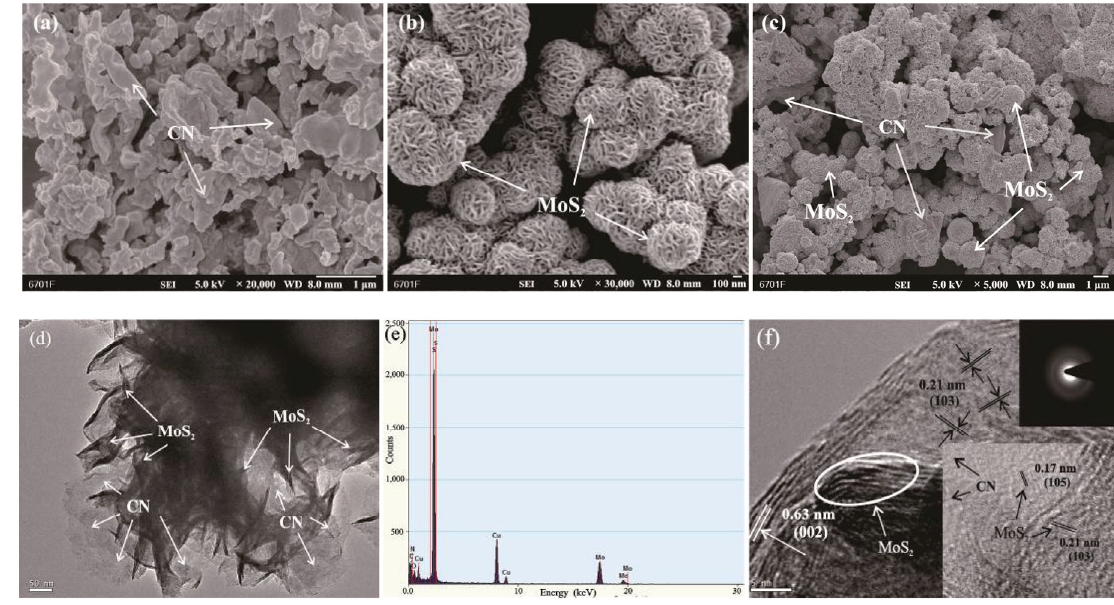
Fig. 2 SEM images of (a) CN, (b) MoS 2 , and (c) CN/MoS 2 ; (d) TEM, (e) EDX, and (f) HRTEM images of CN/MoS 2